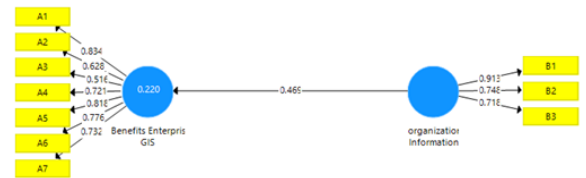
Figure 5. PLS SEM conceptual model for Organization Information